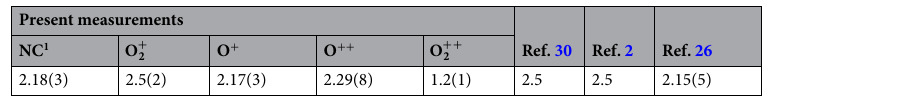
Table 1. Ratio between spin-orbit split components of the core-ionized state Σ Σ − − − − s s 1 ( )/1 ( ) 1 4 1 2